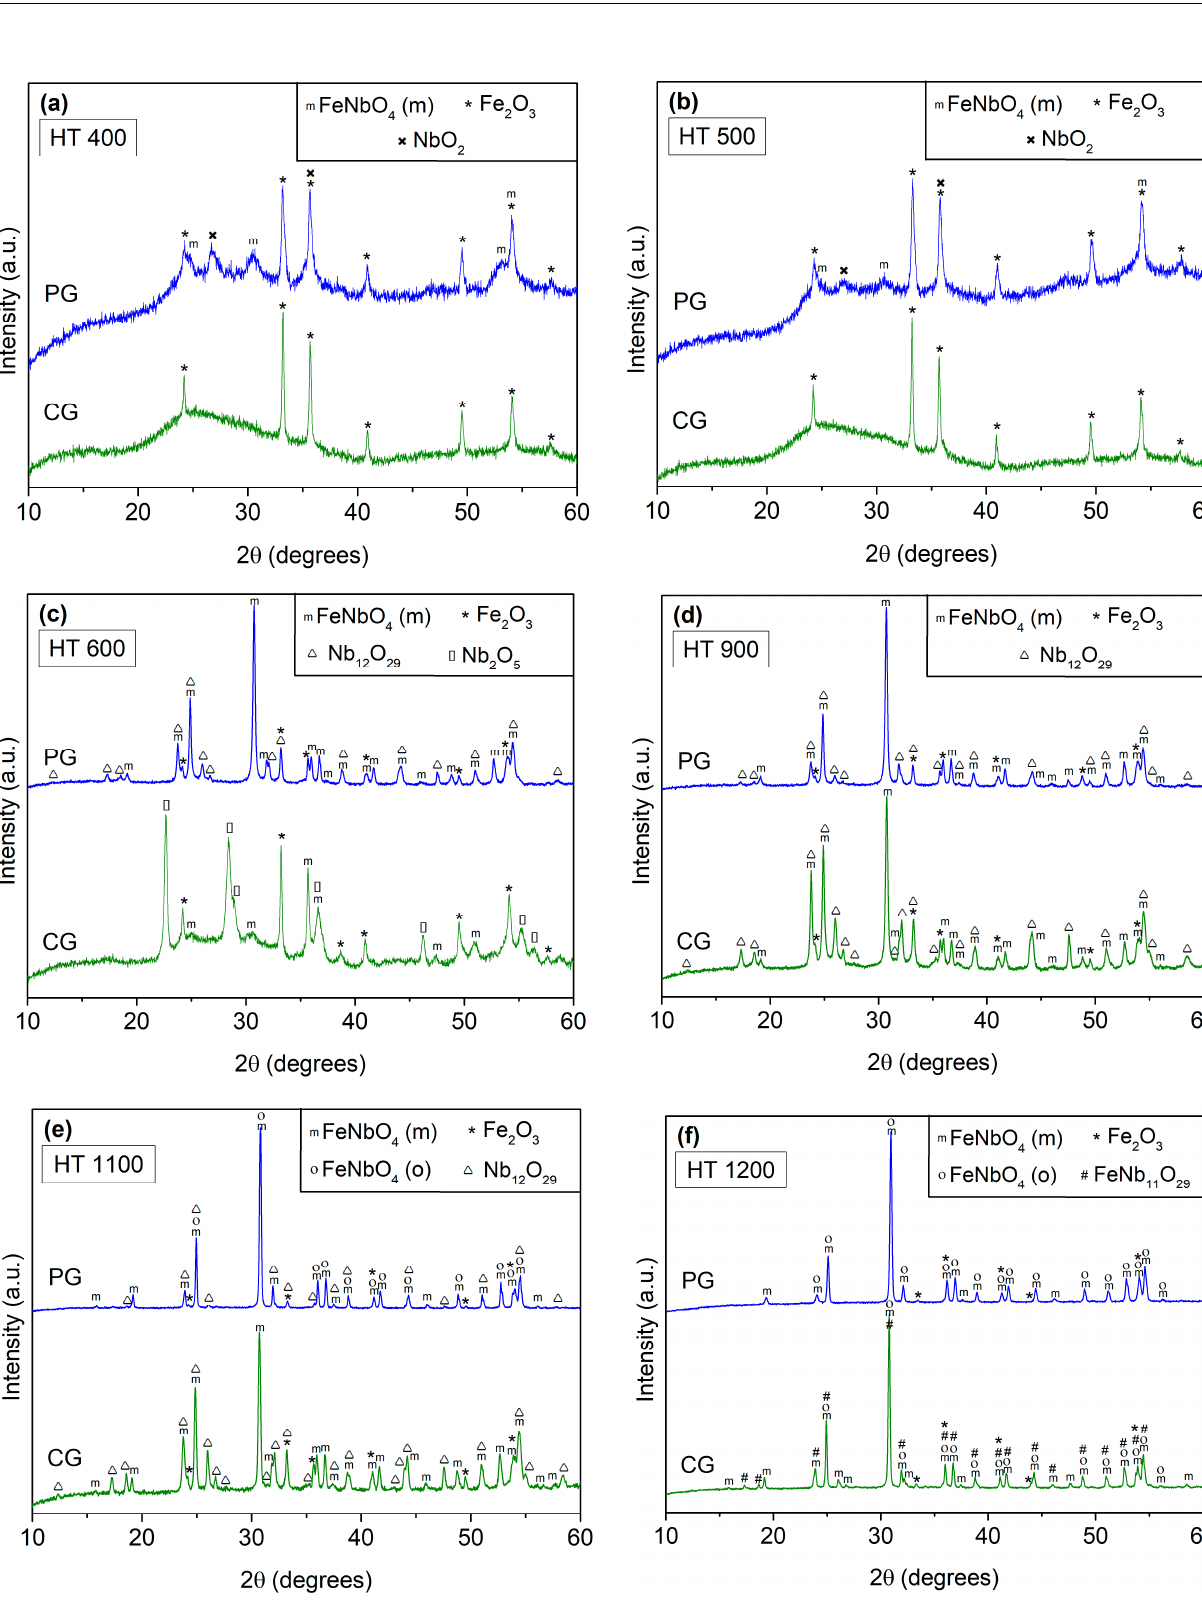
Figure 5. X ‐ ray diffraction patterns of the prepared samples: ( a ) HT 400; ( b ) HT 500; ( c ) HT 600; ( d ) HT 900; ( e ) HT 1100; ( f ) HT 1200. ( d ) HT 900; ( e ) HT 1100; ( f ) HT